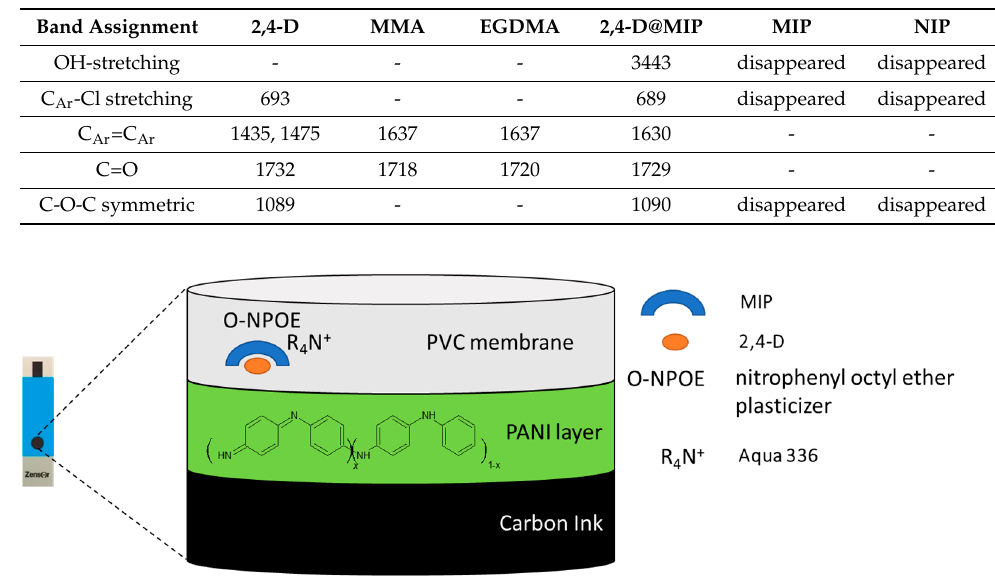
Figure 2. Configuration of the SPE (sensor 4) for the detection of 2,4-D: (bottom layer) screen-printed electrodes (SPEs) based on conductive carbon ink; (middle layer) conductive films of polyaniline (PANI); (top layer) polyvinyl chloride (PVC)/o-nitrophenyl octyl ether (o-NPOE)/molecularly printed polymer (MIP).